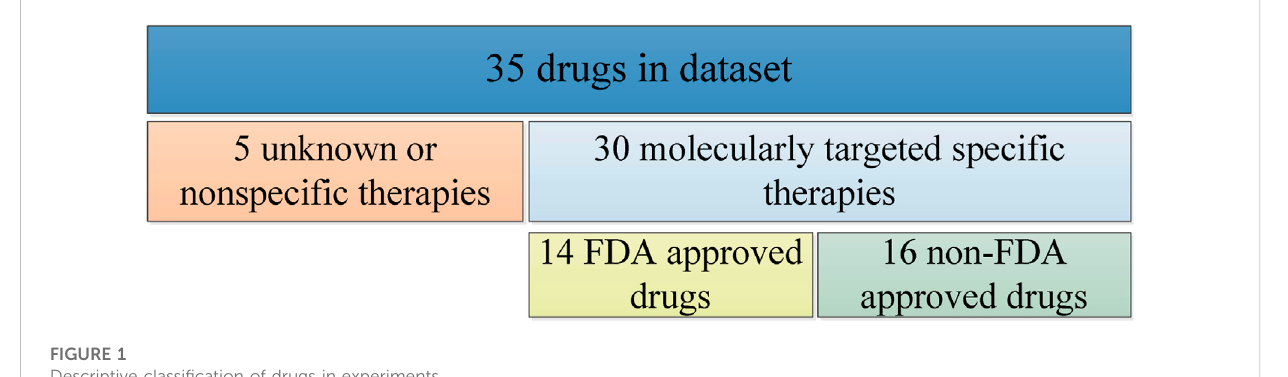
FIGURE 1 Descriptive classi fi cation of drugs in